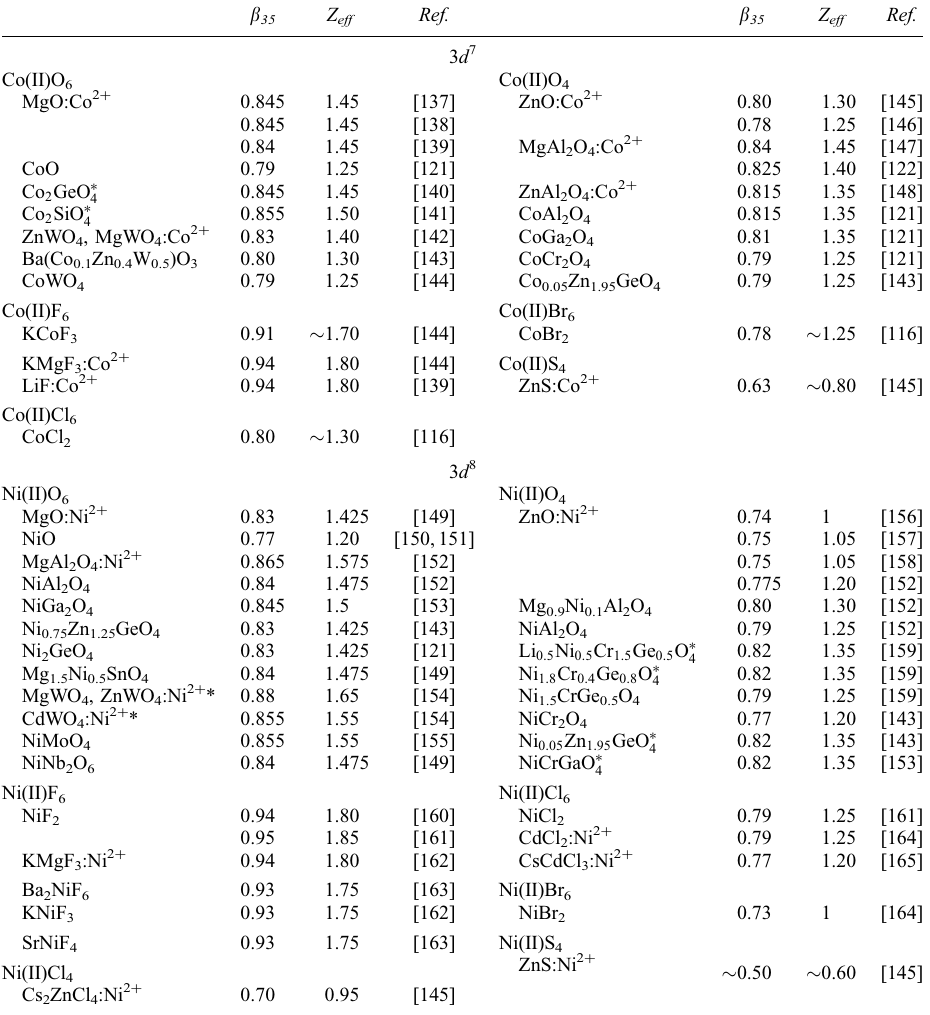
TABLE VI (b) Nephelauxetic Ratios b and Charges Z eff (According to the Jørgensen’s Compromise) Defined in the Text for Selected 3 d 7 and 3 d 8 Group Compounds. b 35